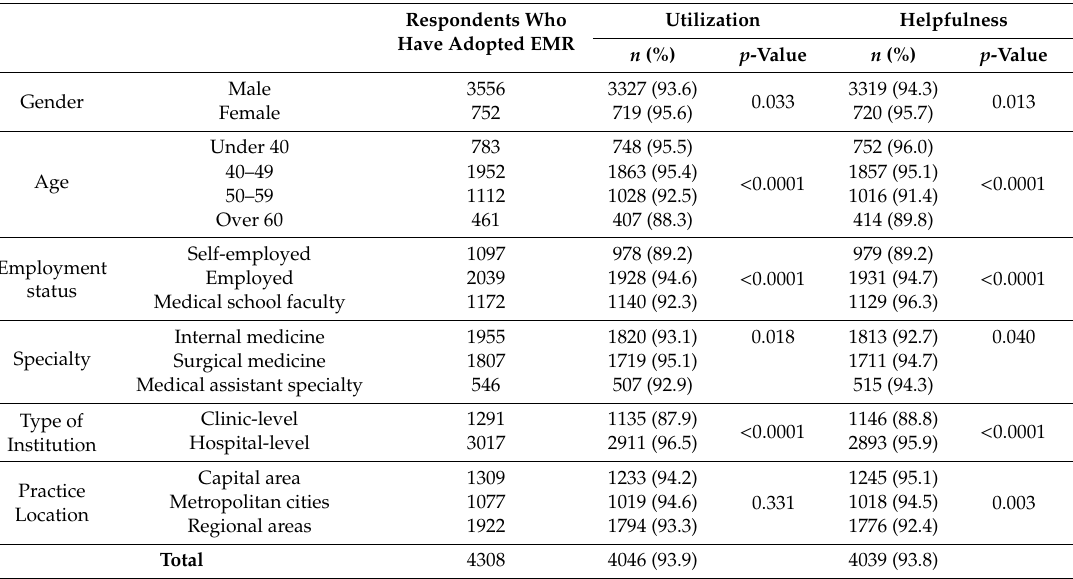
Table 5. Factors related with the utilization and helpfulness of